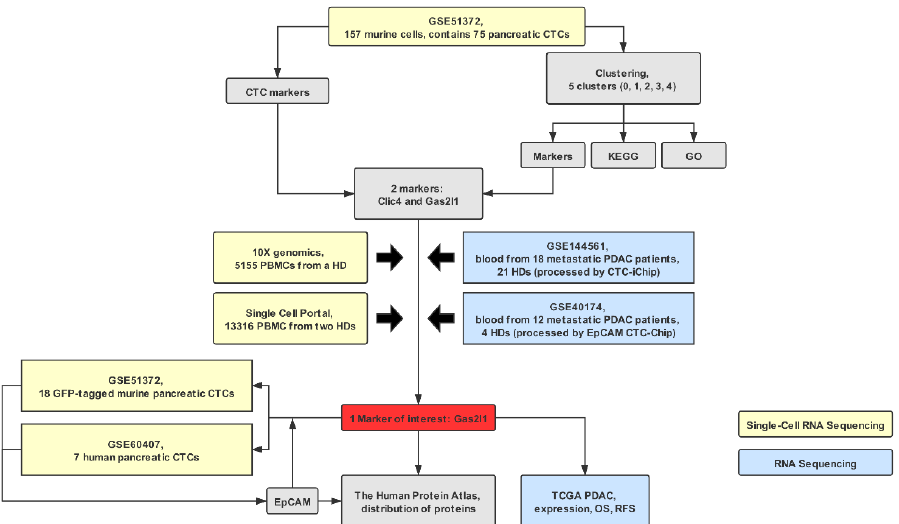
Figure 1. Study flow diagram. CTCs, circulating tumor cells; EPCAM, epithelial cell adhesion molecule; GO, gene ontology; HD, healthy donor; KEGG, Kyoto Encyclopedia of Genes and Genomes; PBMC, peripheral blood mononuclear cells; PDAC, pancreatic ductal adenocarcinoma; OS, overall survival; RFS, relapse-free survival. Cancers 2020 , 12 , x FOR PEER REVIEW